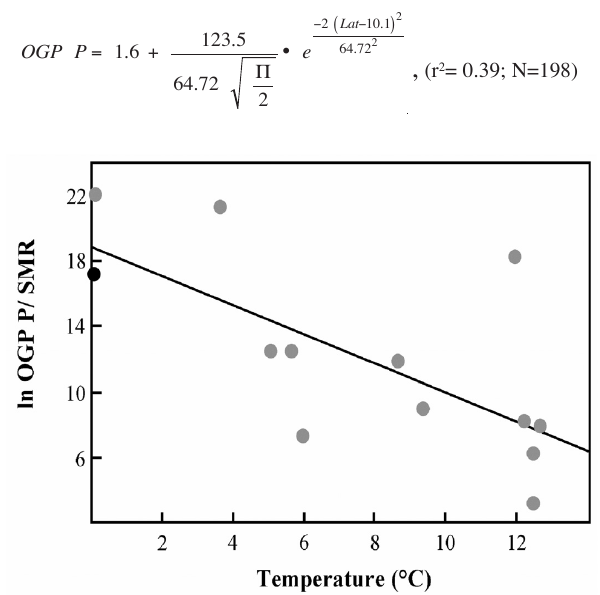
F IG . 4. – Relationship of the ratio of standard metabolic rate (mean SMR ) over growth performance ( P ) to ambient temperature of 7 scallop species (grey dots: A. opercularis , C. islandica , M. varia , M, yessoensis , P. magellanicus , Z. patagonica ; black dot: A. col- becki ). Data presented are resting or standard metabolic rates at normal ambient temperatures. Where seasonal data were available the data were averaged for the whole year (for more details and ref- erences see Heilmayer et al ., 2004). Regression line: OGP P